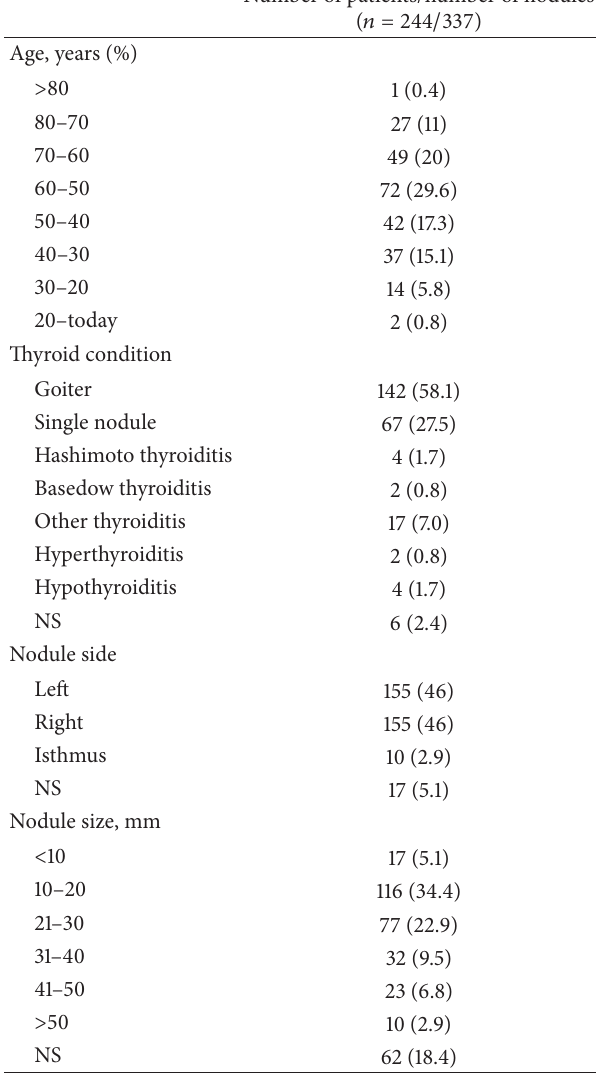
Table 1: Characteristics of patients with follicular lesions of unde- termined significance (FLUS) according to the Bethesda System for Reporting Thyroid Cytopathology (BSRTC).